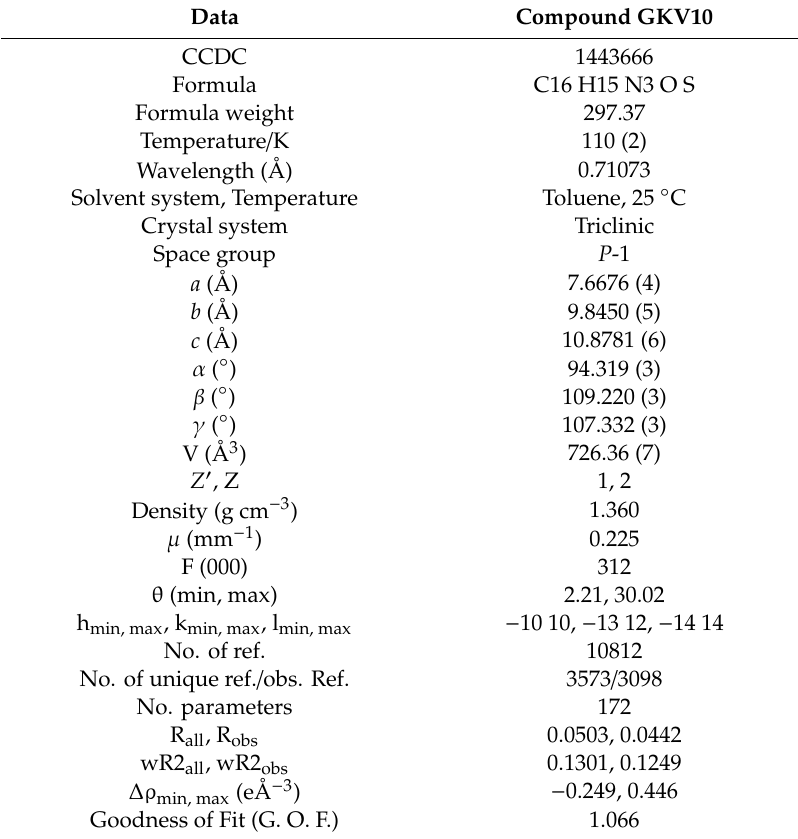
Table 3. Single-crystal data collection and refinement.